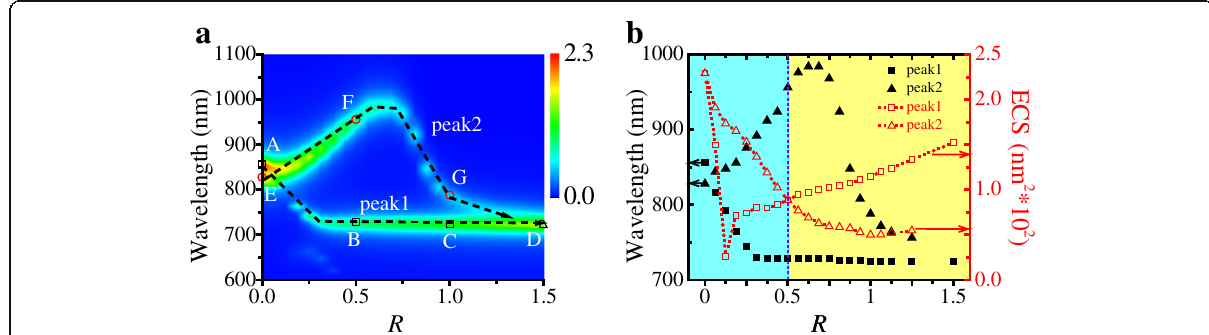
Fig. 2 ECS spectra of Ag TNP dimers. a ECS intensity distribution map as functions of R and wavelength. b ECS resonant wavelength (the dark scatter line ) and intensity (the red short dotted line ) spectra versus R . The square and triangle lines show peak 1 and peak 2, respectively